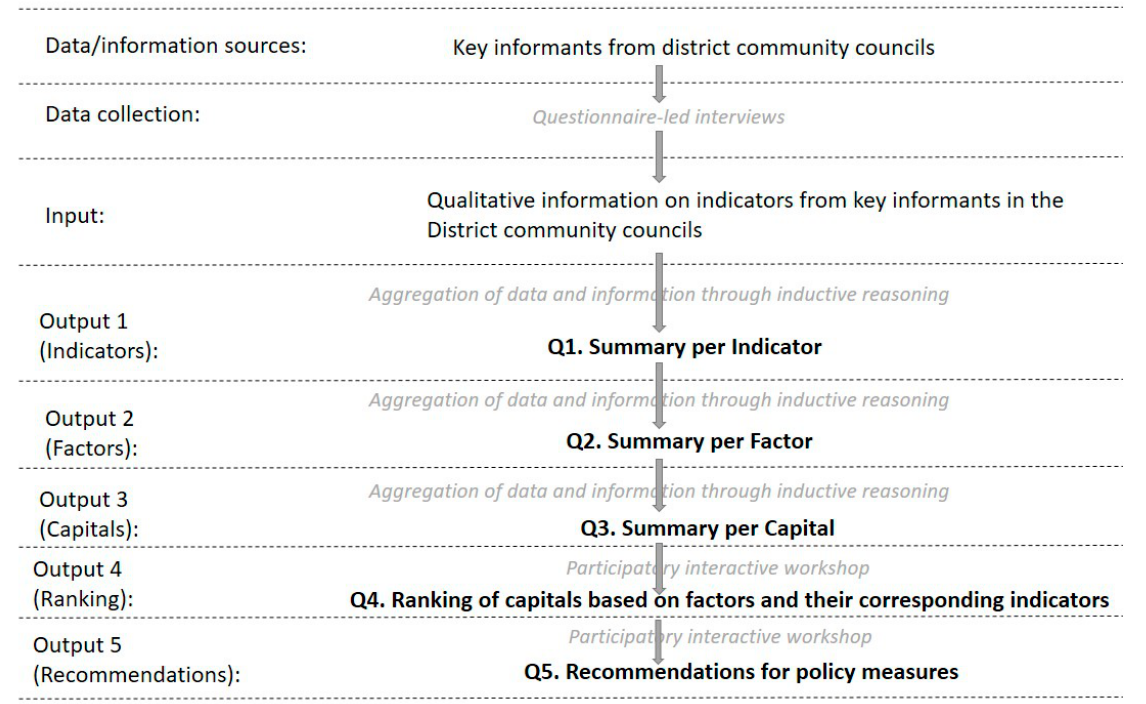
Figure 3. Data and information collection and analysis process applied in Seychelles. Inspired by Williams et al. [19], and Celliers et al. [20].